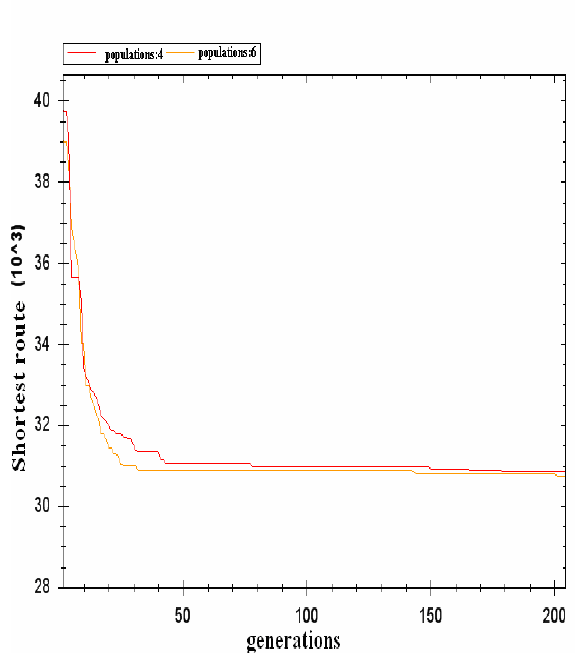
Figure11. The average result 3 of TSP benchmark instances Chn144 by different number of subpopulations